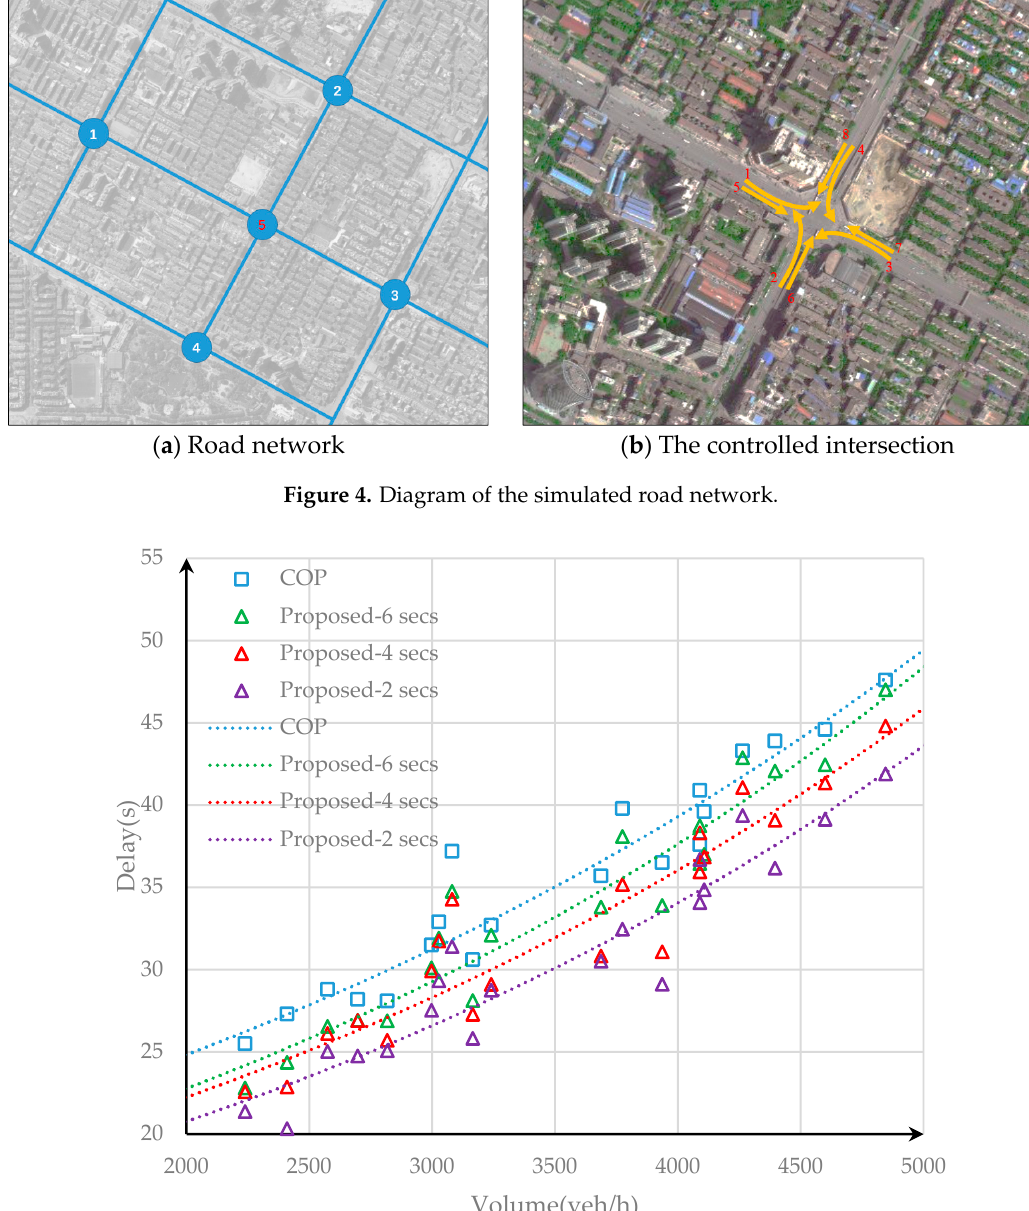
Figure 5. The control performance versus volume for Controlled Optimization of Phases (COP) and the proposed method. Table 2. The average vehicle delay of each phase (volume level is 4500 veh/h).